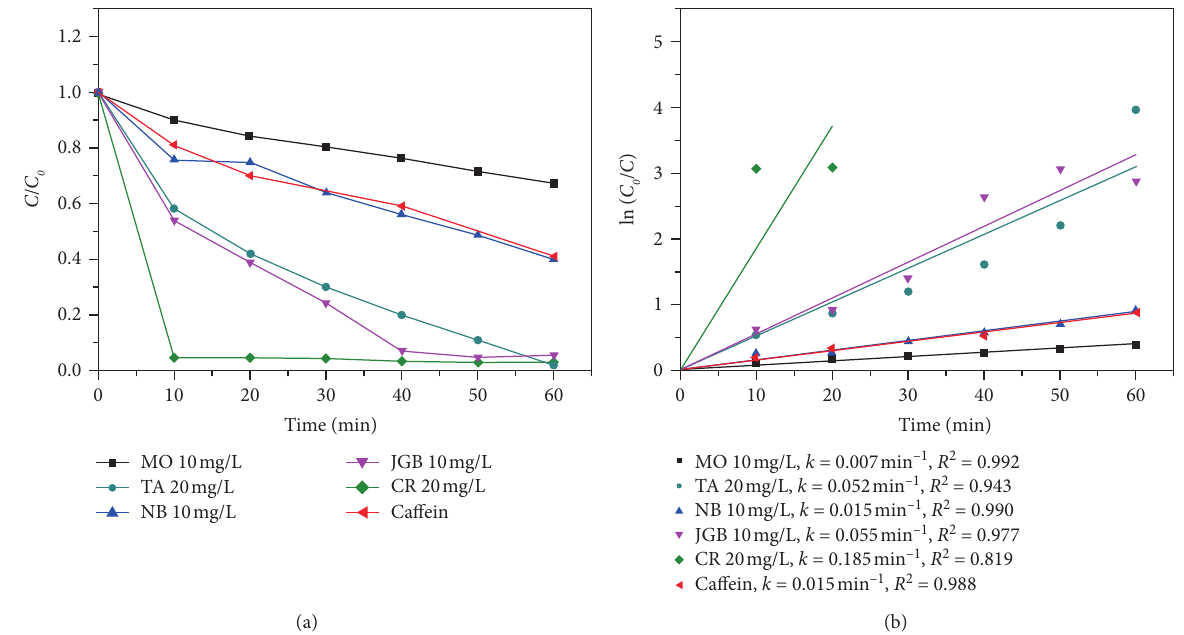
Figure 8: (a) Photodegradation of the different dyes on N-ZnO and (b) the kinetic curves. The reaction conditions: dosage catalyst 0.5g/L, dye concentration of 20mg/L, and pH �